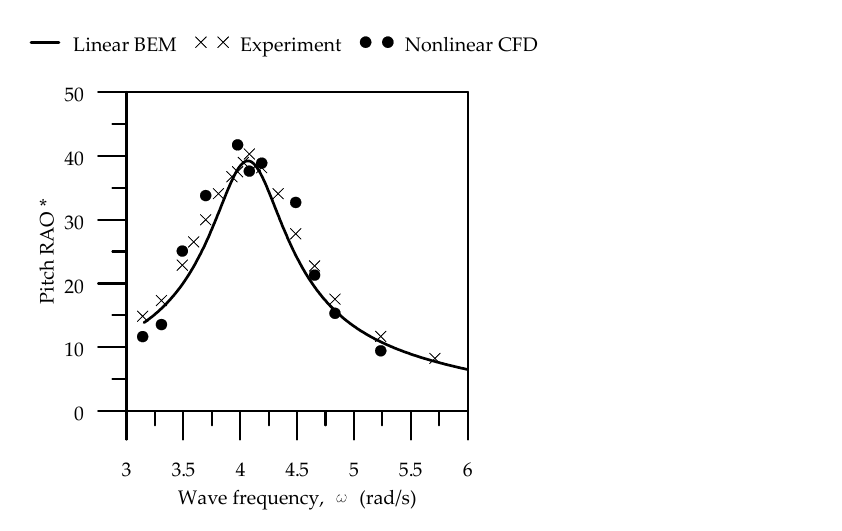
Figure 5. Variation of the non-dimensional pitch RAO * obtained from the linear BEM, nonlinear CFD, and experimental results with the wave frequency (rad/s) for the isolated WEC rotor.